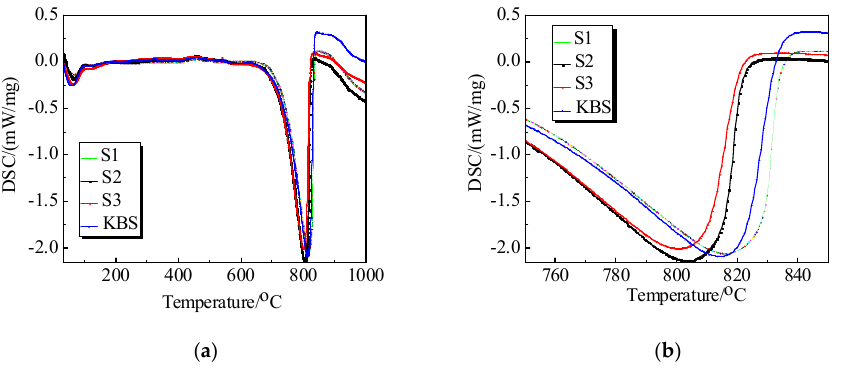
Figure 2. TG ‐ DSC analysis curve of Portland road cement clinker:( a ) graph over the temperature range measured; ( b ) enlarged graph over a limited temperature range. range measured; ( b ) enlarged graph over a limited temperature range.